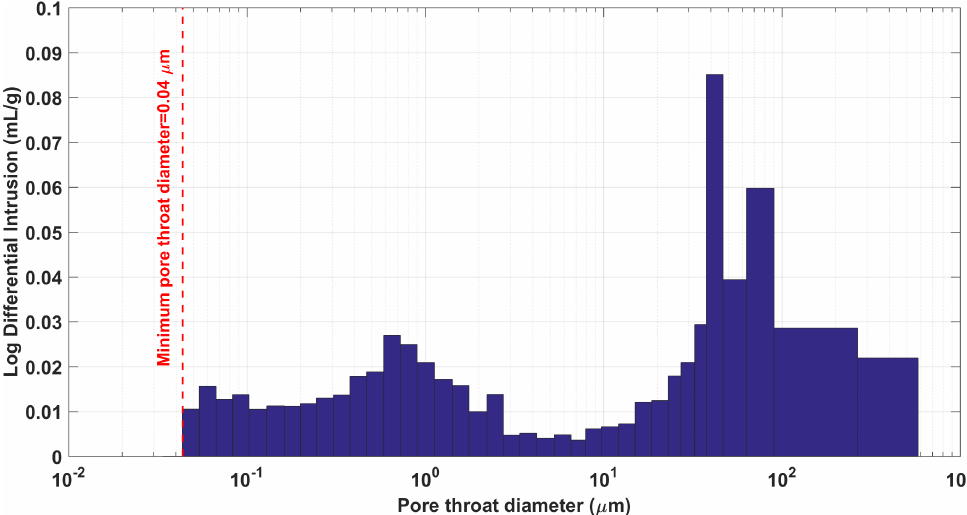
Figure 3. Pore throat size distribution based on the MIP data represented by a plot of the log- differential of mercury volume intrusion (mg/L) vs. the pore throat diameter ( µ